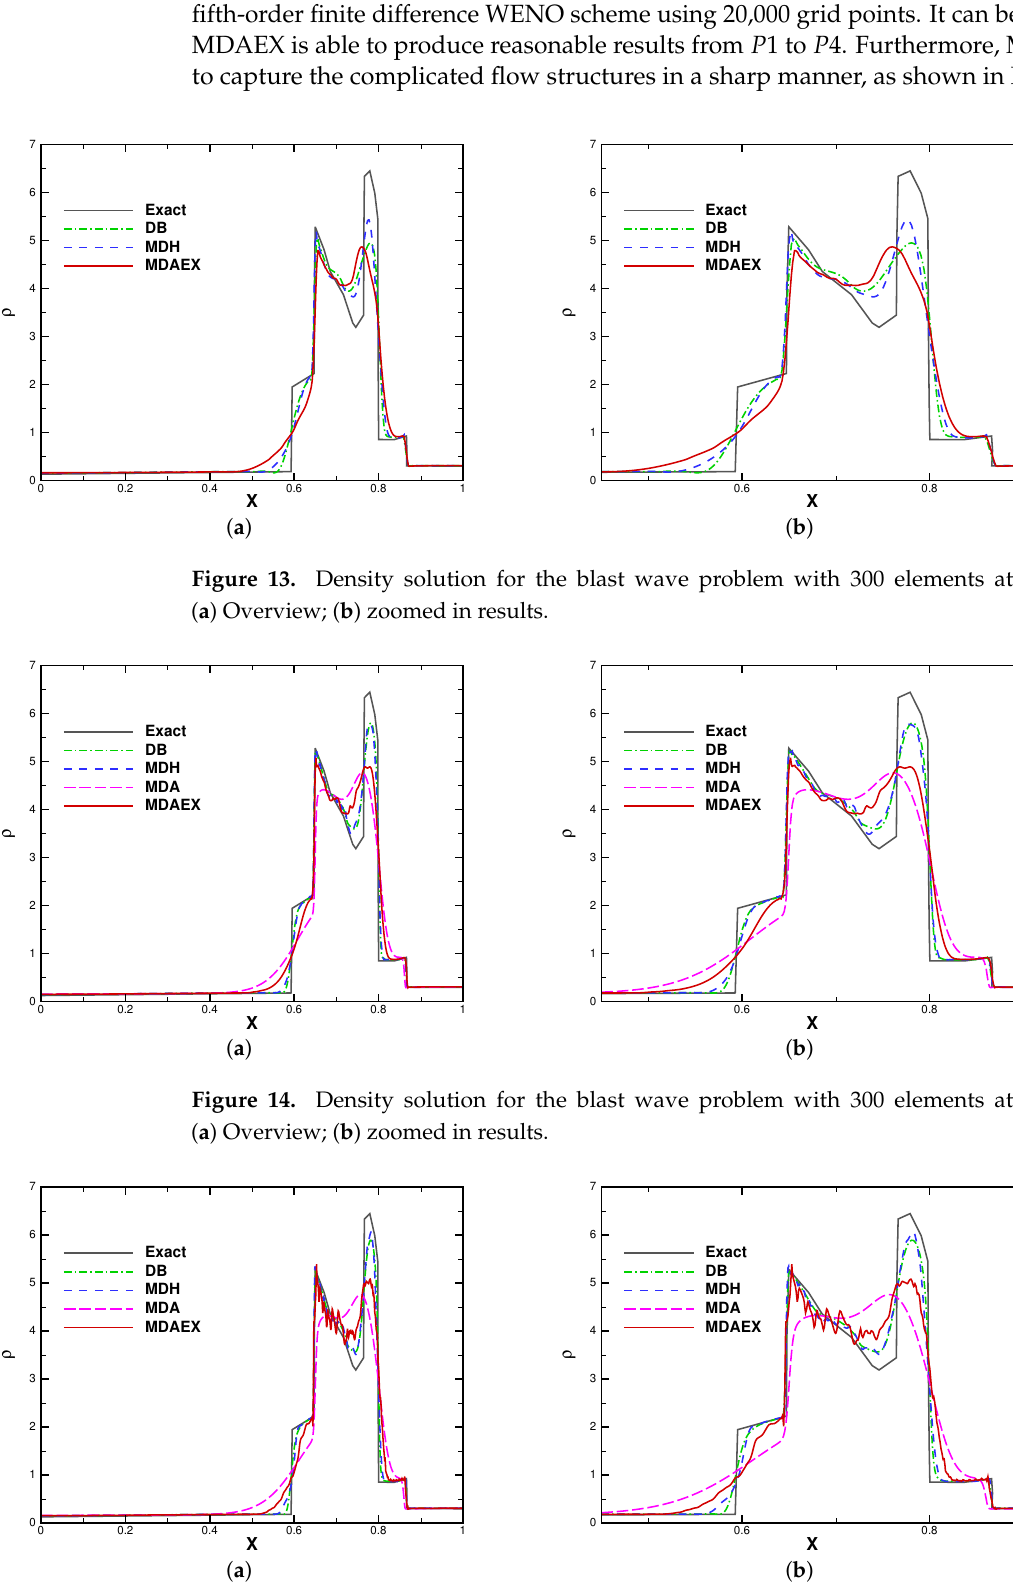
Figure 15. Density solution for the blast wave problem with 300 elements at t = 0.038, P 3. ( a ) Overview; ( b ) zoomed in